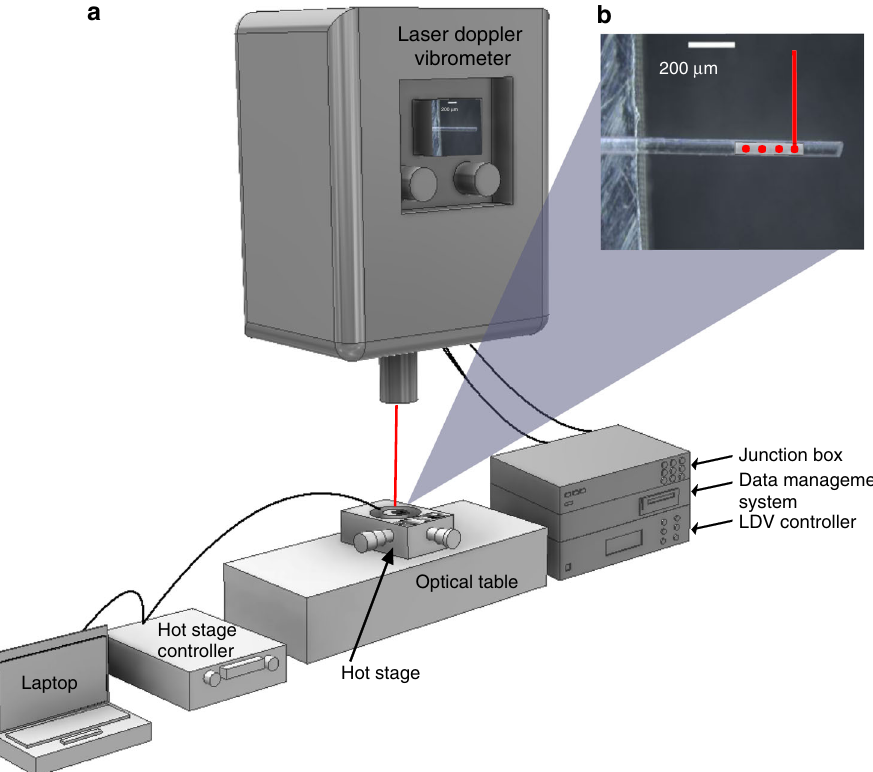
Fig. 1 PMTA schematic and operation. a Schematic representation of the measurement setup for PMTA where the junction box, data management system and laser doppler vibrometer (LDV) controller are used for operating and managing the data generated from the LDV. b Optical image of a single particle of theophylline monohydrate (TP MH) used as a cantilever with a laser spot on top (red) from the LDV as well as a measurement grid with measurement positions (red spots) that are de fi ned using the LDV software. The particle is mounted on a 5 mm × 5 mm aluminium block (left side of the optical image). The piezoelectric crystal was placed adjacent to the aluminium block during the